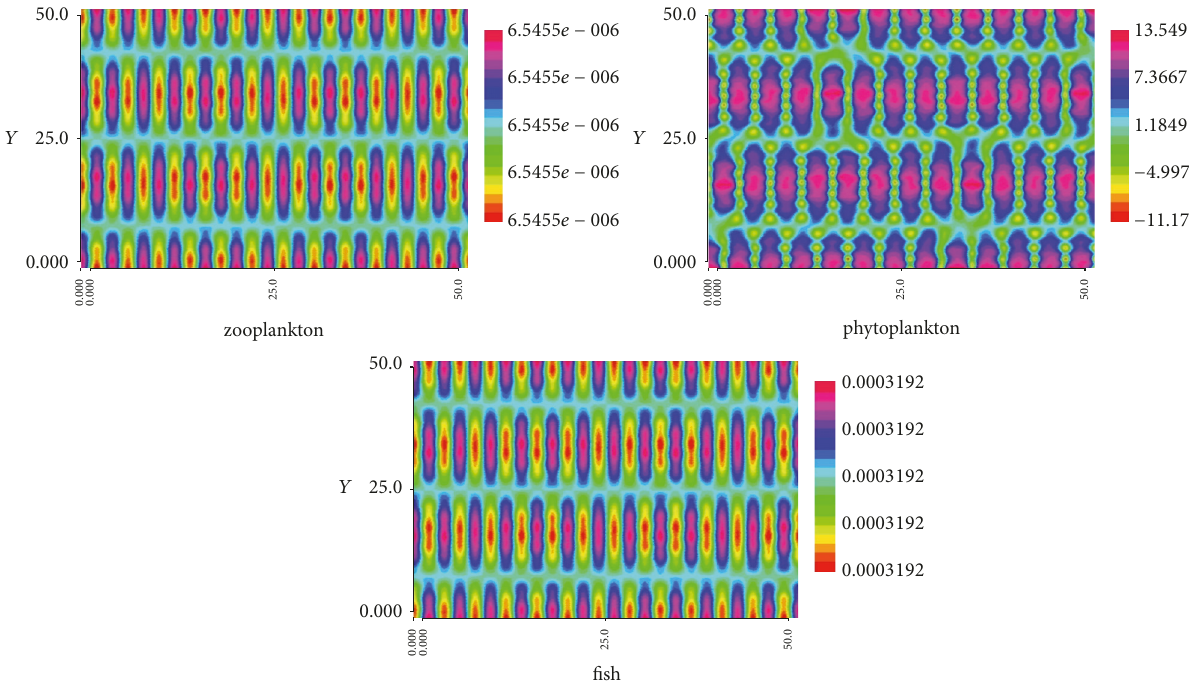
Figure 4: Spatial distribution of the system with 𝑏 0 = 0.4032 and 𝛼 0 = 0.342 .